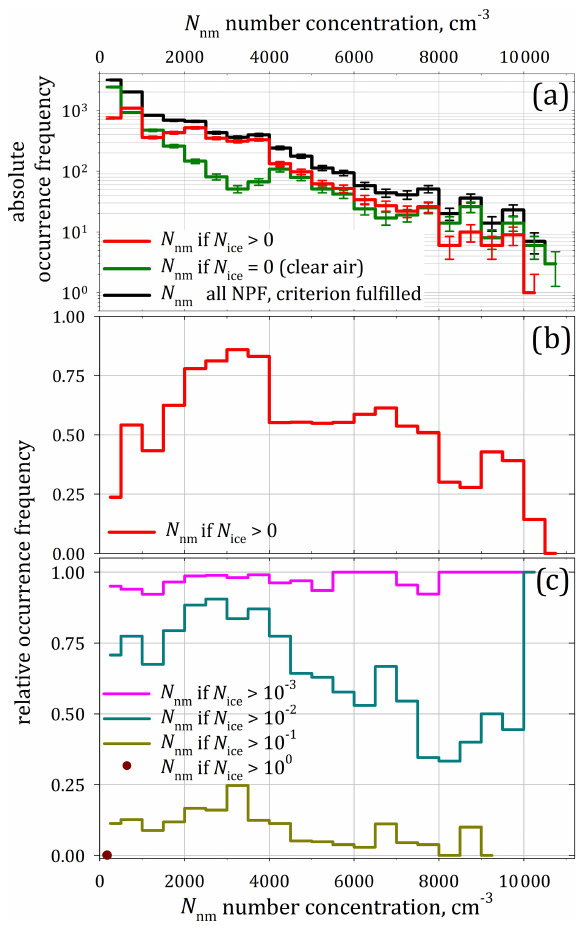
Figure 4. Histograms of the occurrence frequency of number con- centrations N nm of all NPF detections (1Hz resolved) through- out StratoClim 2017. (a) All data of N nm in general (black) and separated concerning coincident detection of cloud (ice) particles in the diameter size range 3µm <d p < 937µm (green: N ice = N 3 − 937 µm = 0cm − 3 ; red: N ice > 0cm − 3 ). The sum of the green and red curve yields the black curve, the vertical bars of which represent the square root of counts. (b) Relative occur- rence frequency of N nm for in-cloud NPF (if detected coincidently with N ice > 0cm − 3 ), normalised with respect to all NPF detec- tions, i.e. the ratio of the absolute occurrence frequencies (in red and black in panel a ). (c) Relative occurrence frequency of N nm for in-cloud NPF if detected coincidently with various N ice levels, which were normalised with respect to those NPF detections with N ice > 0cm − 3 , (in red; panel b